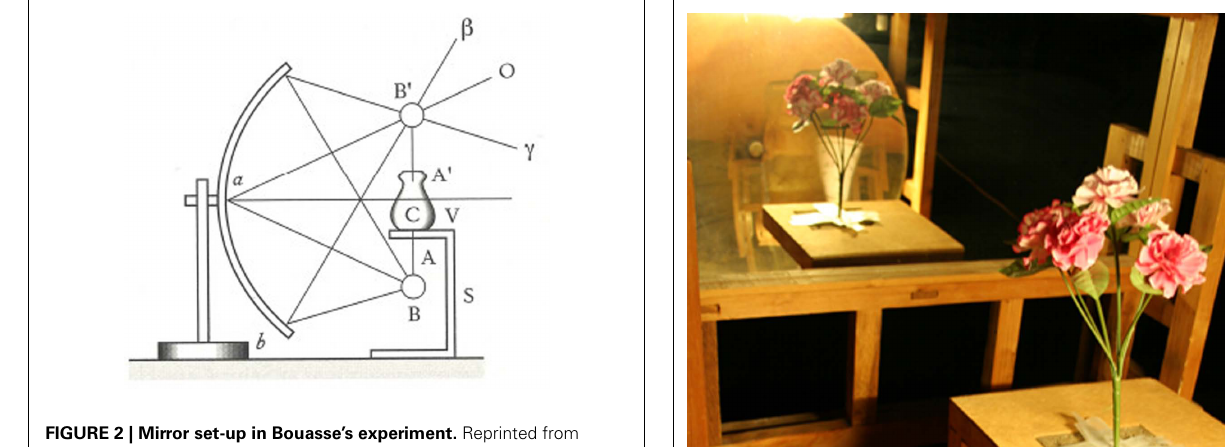
FIGURE 2 | Mirror set-up in Bouasse’s experiment. Reprinted from ECRITS by Jacques Lacan, translated by Bruce Fink. English translation copyright © 2006, 2002 byW.W. Norton & Company, Inc. Used with permission of the publisher,W.W. Norton & Company, Inc.